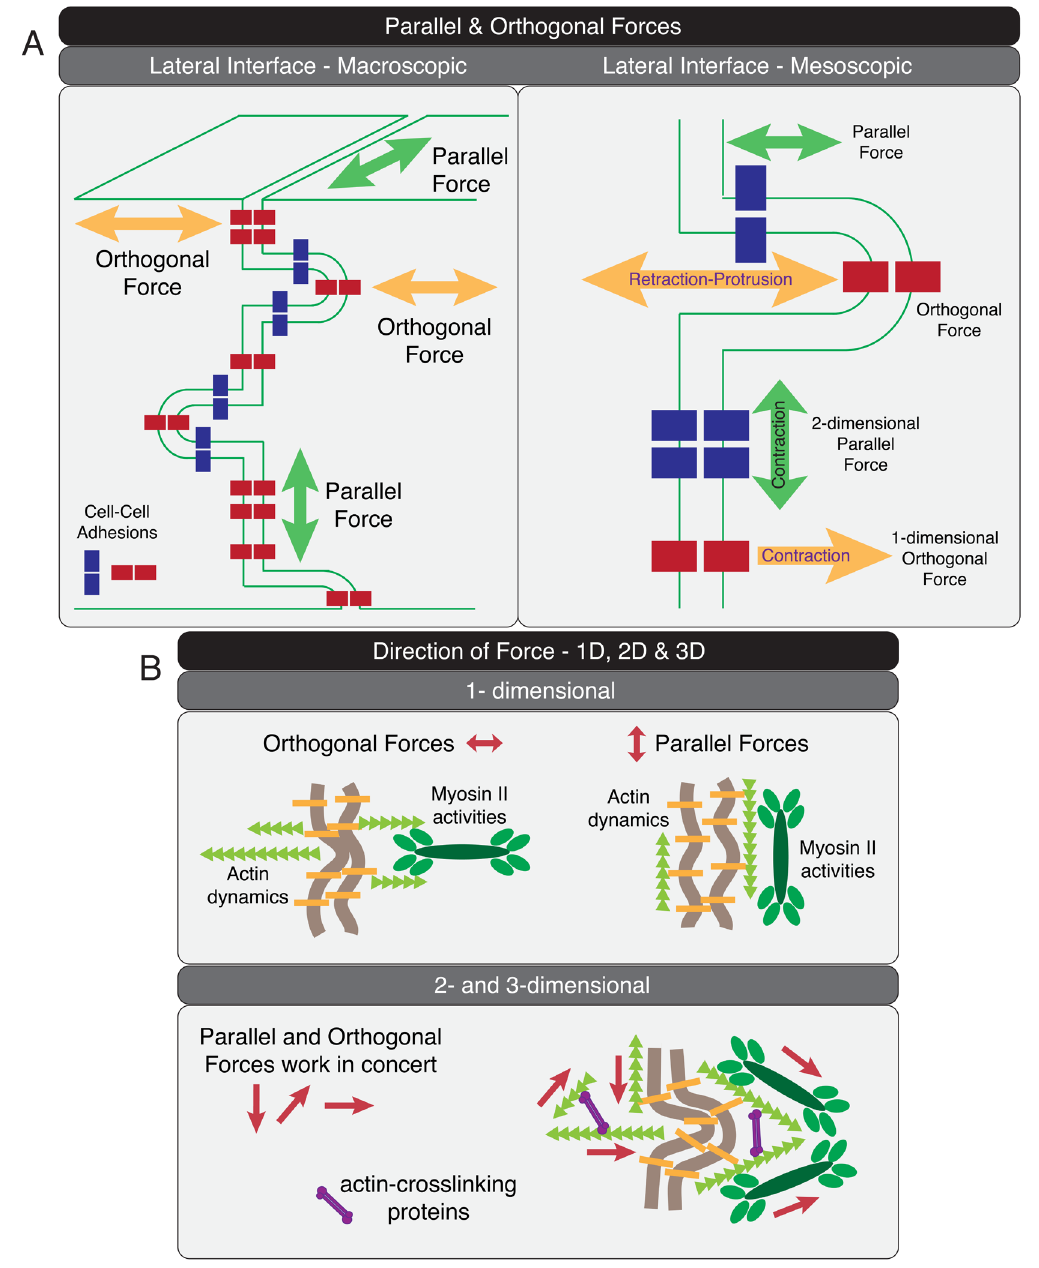
Figure 2. Direction of forces at the lateral cell–cell adhesion interface. ( A ) Parallel and orthogonal forces are shown at the macroscopic multi-cellular (left panel) and mesoscopic cellular (right panel) scales. Cell–cell adhesions at the tip of a lateral membrane protrusion experience orthogonal force, whereas cell–cell adhesions at the trunk of the same membrane protrusion experience parallel force (right panel). ( B ) Forces in one, two, and three dimensions can be generated through spatial organization of actin dynamics and actomyosin activities. Orthogonal and parallel one-dimensional forces can be generated with actin filaments arranged orthogonal and parallel to the plasma membrane, respectively (upper panel). Orthogonal and parallel two- and three-dimensional forces can be generated with a cross- linked actin network to support processes on the lateral cell–cell adhesion interface (lower